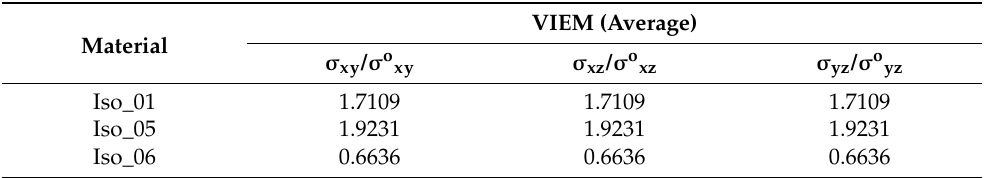
Table 18. Normalized shear stress components ( σ xy / σ o xy , σ xz / σ o xz and σ yz / σ o yz ) within the isotropic spherical inclusion due to remote shear loading ( σ o xy , σ o xz and σ o yz ). VIEM (Average) Material σ xy / σ o xy σ xz / σ o xz σ yz / σ o yz Iso_01 1.7109 1.7109 1.7109 Iso_05 1.9231 1.9231 1.9231 Iso_06 0.6636 0.6636